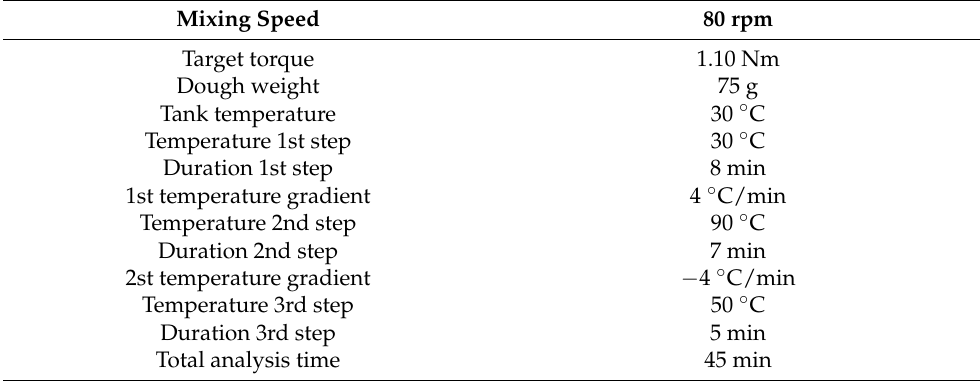
Table 3. Instrumental settings defined in the Mixolab for running the